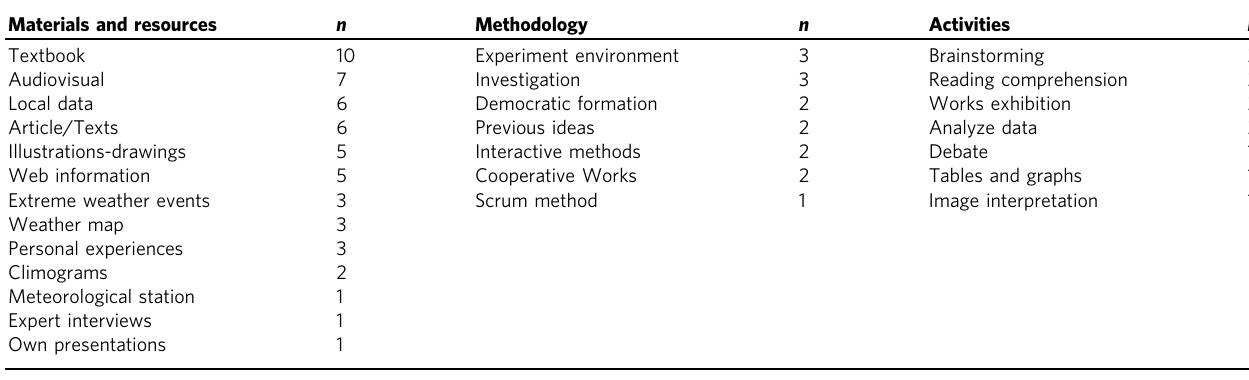
Table 3 Methodological aspects that the teachers use to explain the climate. Materials and